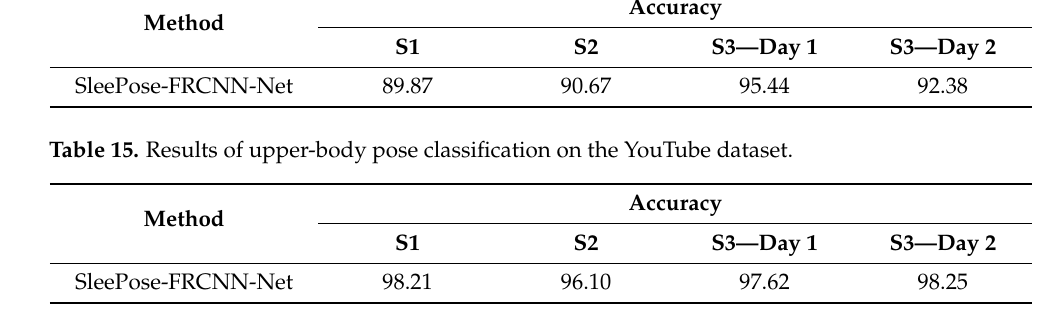
Table 14. Results of head pose classification on the YouTube dataset.